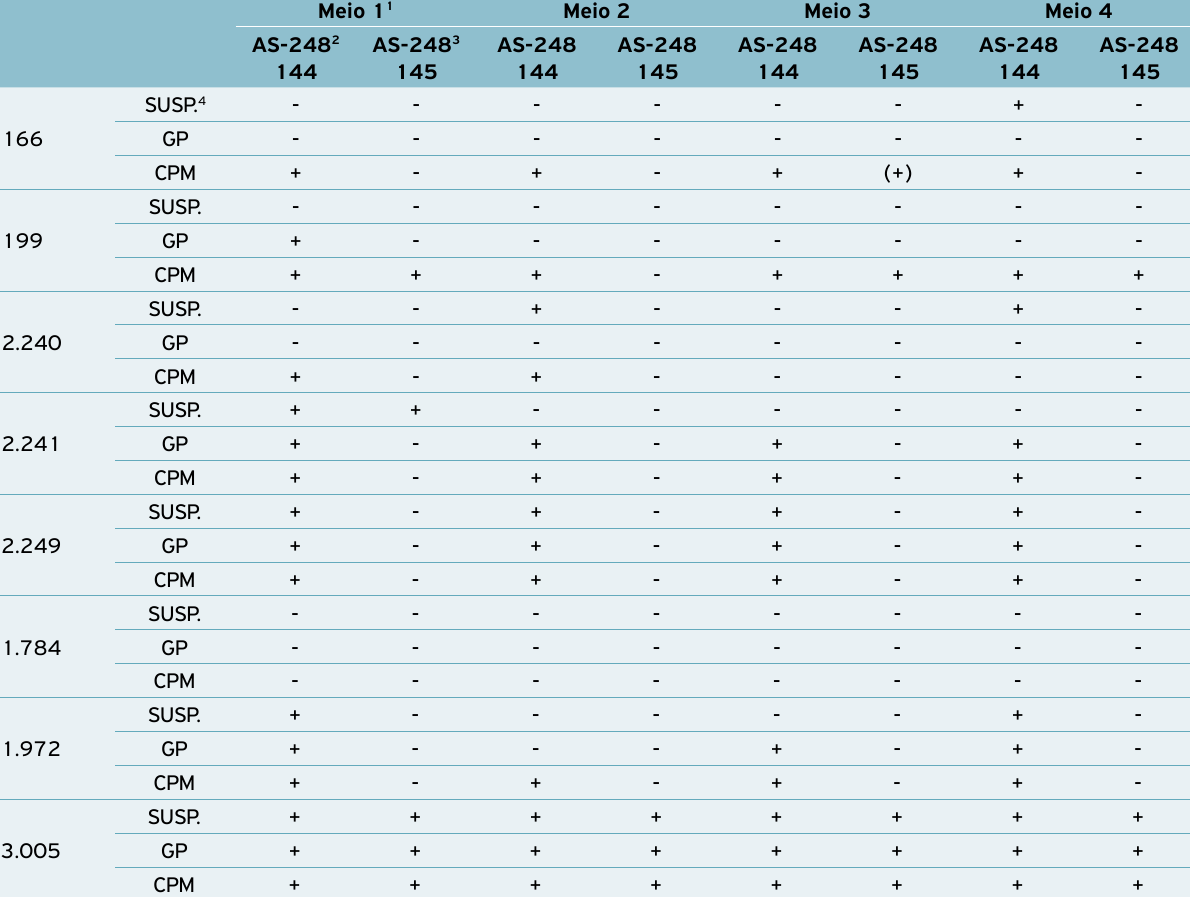
Tabela 5. Relacionamento serológico entre antissoros contra Pseudomonas syringae pv. garcae e demais bactérias patogênicas ao cafeeiro em diferentes meios de dupla